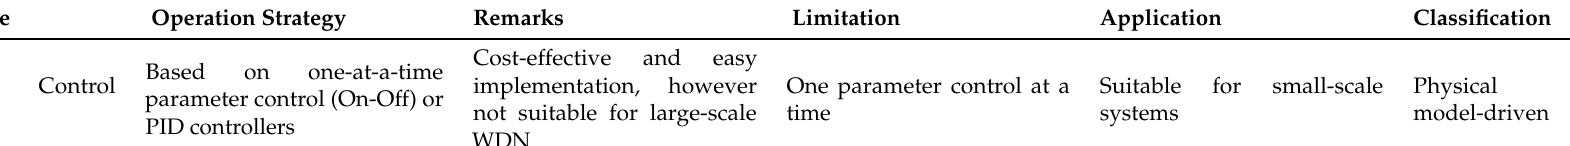
Table 4. Brief summary of control techniques commonly employed in pressure control of water distribution